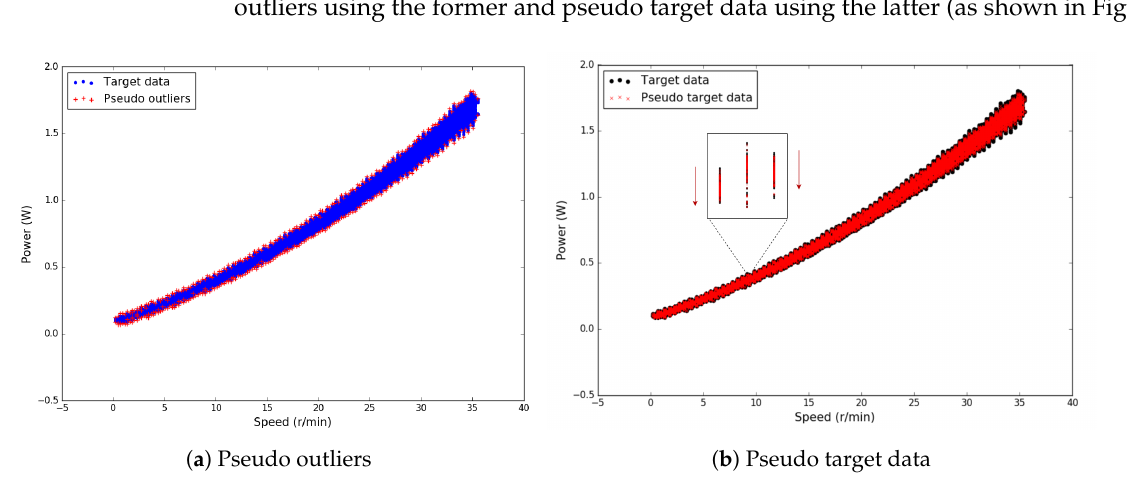
Figure 3. Pseudo outliers and pseudo target